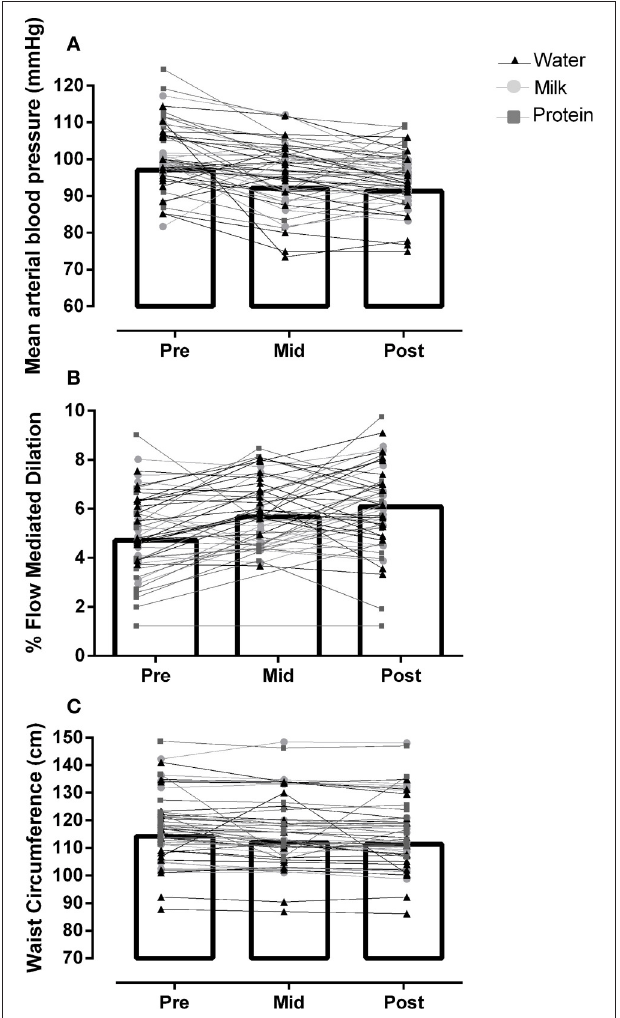
FIGURE 4 | Data for (A) mean arterial blood pressure (MAP), (B) percentage flow-mediated dilation (%FMD), and (C) waist circumference, before (Pre), after 6 weeks (Mid), and 12 weeks (Post) mean for all participants (bar graph, all main effect of time p < 0.05) and individual data (line and symbols per beverage group, no group interaction p >